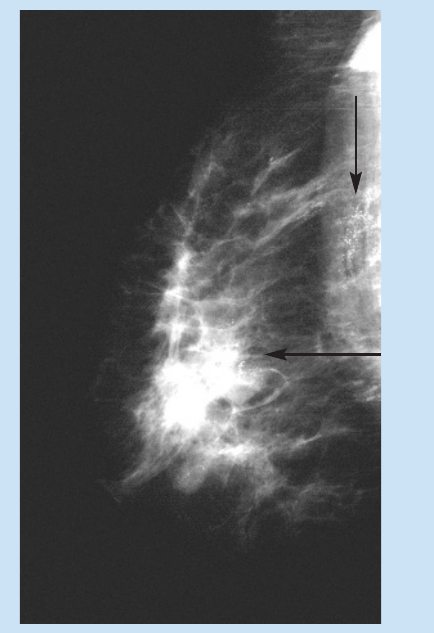
tions.Fig. Fig. 1b. Mammogram showing nodes, micro- calcifications and patchy spiculated densities.